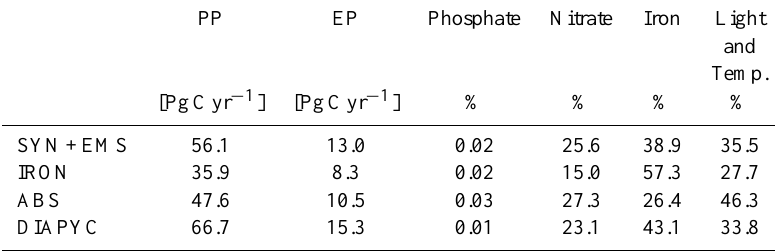
Table 2. Production weighted nutrient limitation in percent of total primary production in the model for a 5-year mean (2003–2007). PP EP Phosphate Nitrate